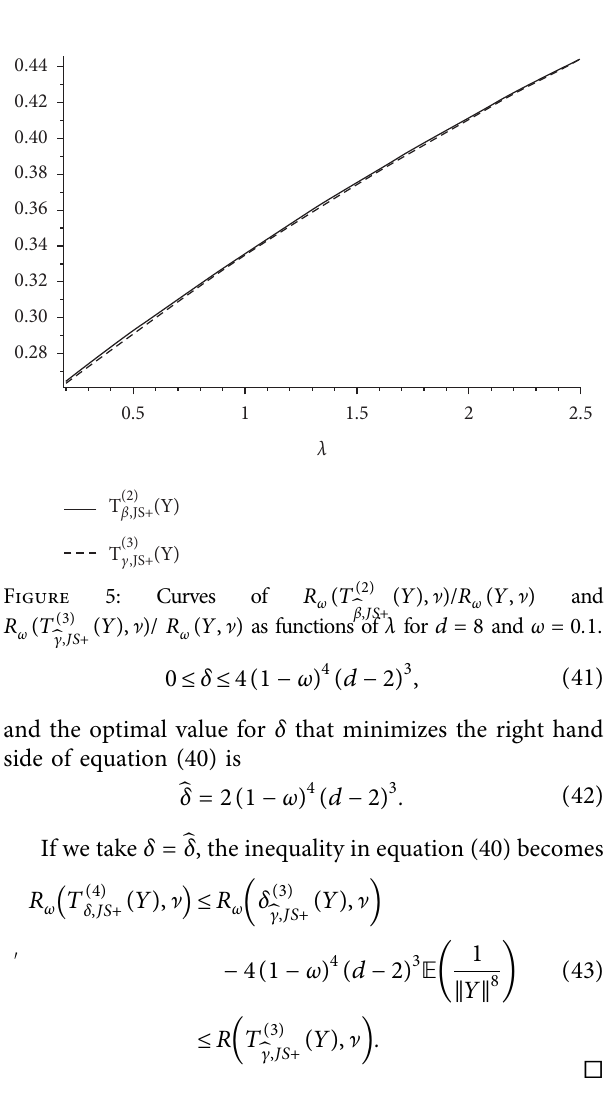
Figure 4: Curves of R R ( Y, ] ) as functions of λ for d � 8 and ω � 0 . 5. ω